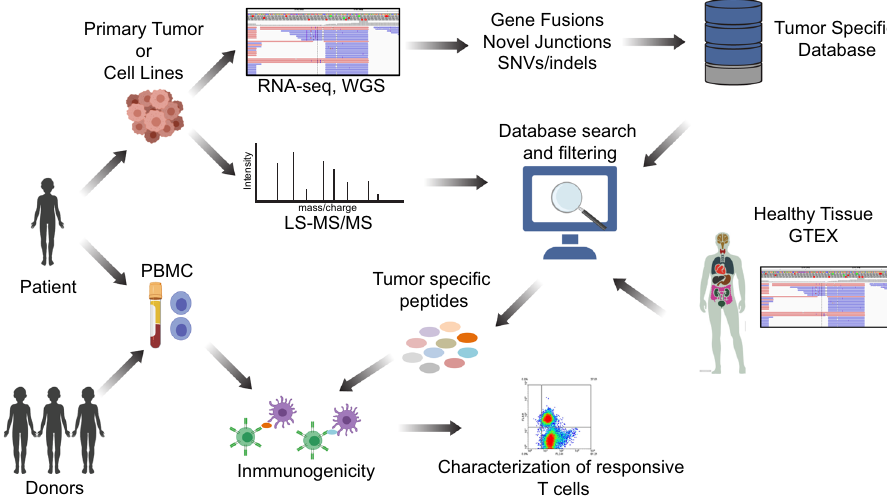
Fig. 1 Proteogenomic approach to identify tumor-speci fi c antigens in pediatric brain tumors. Schematic representation of the entire work fl ow is shown. Tumor tissue samples were obtained from patients, and WGS and RNA-seq were performed to identify tumor-speci fi c genomic aberrations (SNV/indels, junctions, and fusions). Protein lysates were subjected to LC-MS/MS shotgun proteomics and spectra were searched against tumor-speci fi c databases originating from tumor WGS and RNA-seq. MS-identi fi ed peptides were fi ltered using genomic and proteomic data from normal tissues to eliminate potential non-annotated normal proteins. Finally, to evaluate tumor-speci fi c peptides for immunogenicity, autologous and allogeneic T cells were selected and expanded against the peptides and characterized for phenotype and